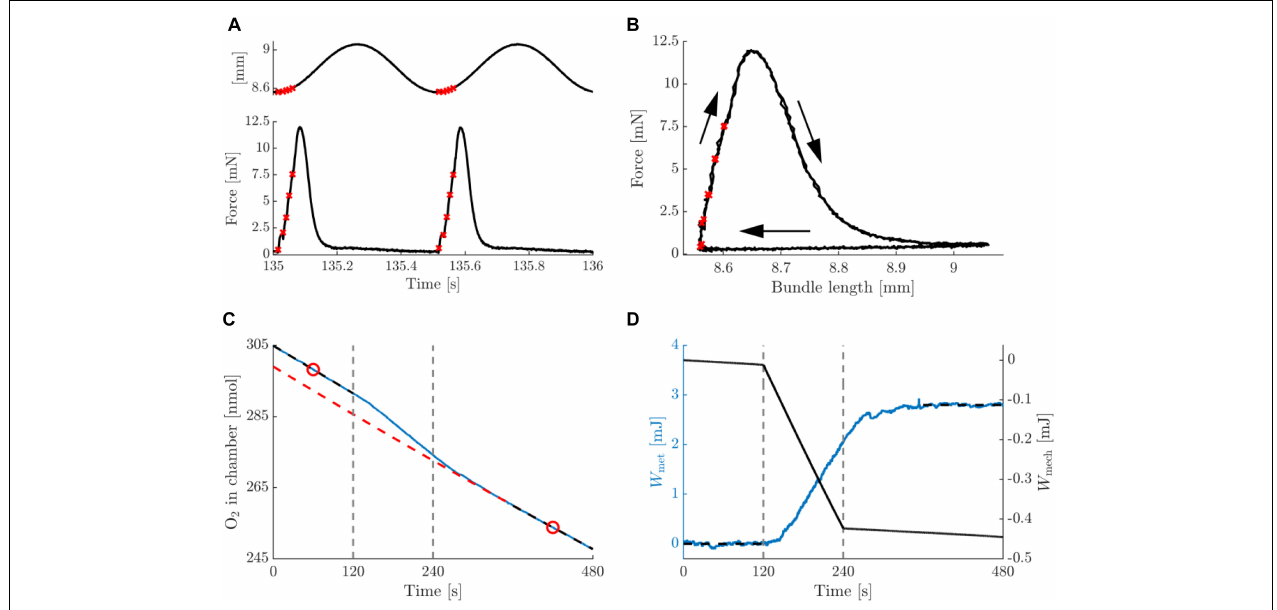
FIGURE 4 | Summary data for a typical example of an eccentric contraction with amplitude 0.25 mm and movement frequency 2 Hz, pre-blebbistatin. Figure lay-out identical to that of Figure 3 ; see legend thereof. TABLE 3 | Mean ± SD mechanical power and net metabolic power for all conditions, averaged across mice. Concentric contraction Eccentric contraction Difference of absolute values Pmech (W/kg), 0.25 mm, 2 Hz, B0 2.7 ± 0.6 − 3.1 ± 1.2 − 0.4 ± 0.9 Pmech (W/kg), 0.25 mm, 3 Hz, B0 3.6 ± 1.5, N = 7 n.a. n.a. Pmech (W/kg), 0.50 mm, 2 Hz, B0 3.9 ± 1.0, N = 6 n.a. n.a. Pmet (W/kg), 0.25 mm, 2 Hz, B0 21.4 ± 3.2 15.0 ± 4.3 6.4 ± 5.1 Pmet (W/kg), 0.25 mm, 3 Hz, B0 23.4 ± 6.8, N = 7 n.a. n.a. Pmet (W/kg), 0.50 mm, 2 Hz, B0 23.4 ± 4.3, N = 6 n.a. n.a. Pmech (W/kg), 0.25 mm, 2 Hz, B1 − 0.1 ± 0.1, N = 7 − 0.1 ± 0.1, N = 6 − 0.0 ± 0.0, N = 6 Pmet (W/kg), 0.25 mm, 2 Hz, B1 7.4 ± 1.6, N = 7 8.8 ± 2.8, N = 6 − 1.3 ± 1.3, N = 6 N = 9 mice, unless indicated otherwise. In all trials, length varied sinusoidally with amplitude 0.25 or 0.50 mm, and movement frequency was either 2 or 3 Hz. At both movement frequencies, five pulses (at 100 Hz) were delivered at either 90 (concentric) or 270 (eccentric) degrees of phase relative to the start of the sine wave, during each cycle. B0: pre-blebbistatin. B1: post-blebbistatin. The values reported in column 4 are the means and standard deviations of the paired differences between concentric and eccentric contraction. n.a., not available. TABLE 4 | Mean ± SD mechanical efficiency and the fraction of metabolic power required for the activation process, for all conditions, averaged across mice. Concentric Eccentric Difference of absolute values Efficiency, 0.25 mm, 2 Hz 0.12 ± 0.03 − 0.22 ± 0.08 − 0.10 ± 0.06 Efficiency, 0.25 mm, 3 Hz 0.15 ± 0.03, N = 7 n.a. n.a. Efficiency, 0.50 mm, 2 Hz 0.16 ± 0.02, N = 6 n.a. n.a. Activation fraction of Pmet, 0.25 mm, 2 Hz 0.37 ± 0.07, N = 7 0.56 ± 0.17, N = 6 − 0.18 ± 0.12, N = 6 N = 9 mice, unless indicated otherwise. In all trials, length varied sinusoidally with amplitude 0.25 or 0.50 mm, and movement frequency was either 2 or 3 Hz. At both movement frequencies, five pulses (at 100 Hz) were given at either 90 (concentric) or 270 (eccentric) degrees of phase relative to the start of the sine wave, during each cycle. The values reported in column 4 are the means and standard deviations of the paired differences between concentric and eccentric contraction. Values in this table were calculated from the raw data underlying Table 3 . n.a., not